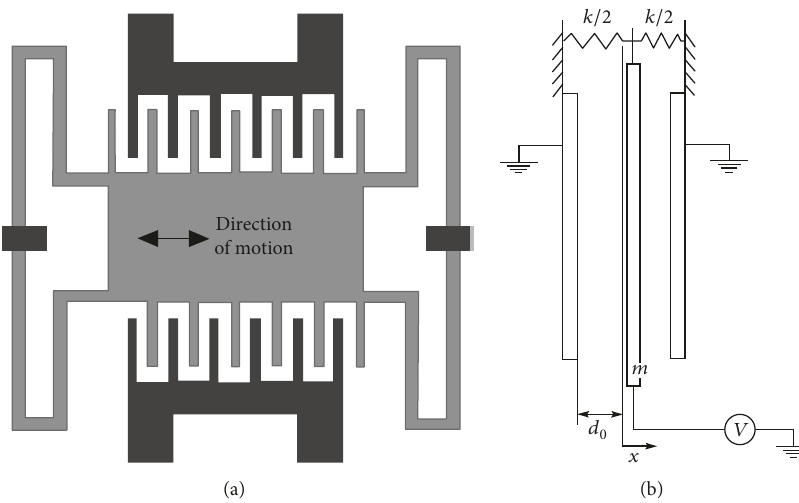
Figure 1: (a) In-plane gap closing. (b) Microelectromechanical system